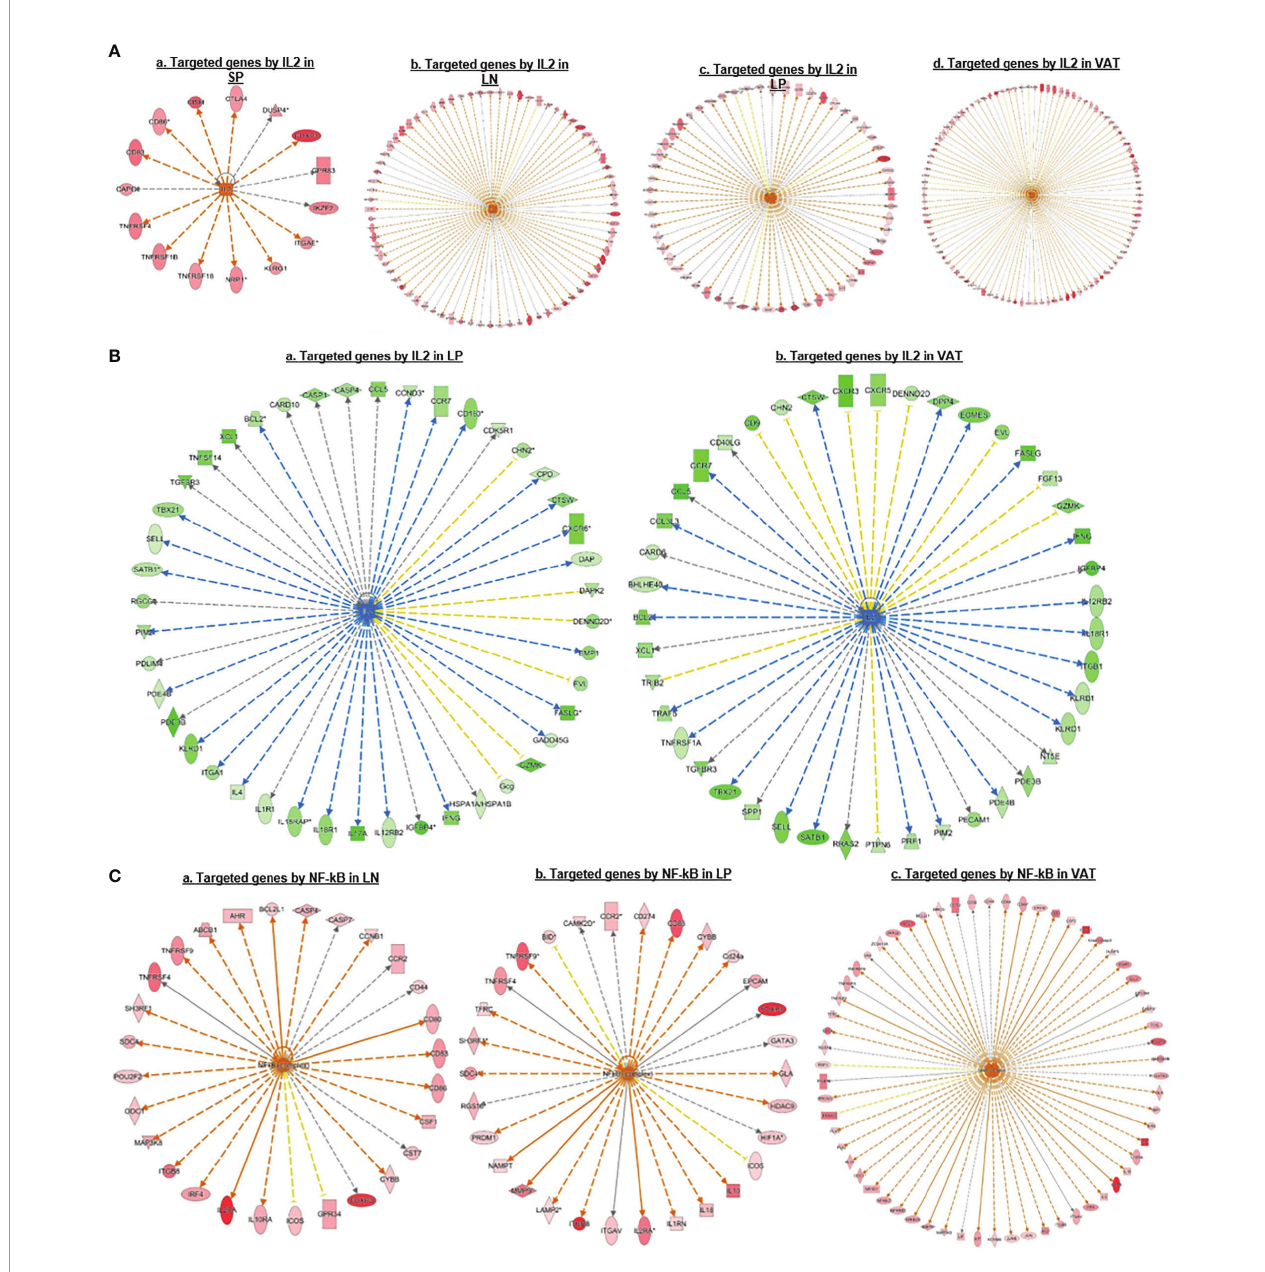
FIGURE 4 | (A) IPA upstream regulator predictions of upregulated genes in Treg suggest that IL 2 is a universal regulator of Treg in different tissues; and its function could be ampli fi cated from lymphoid tissues to non-lymphoid tissues. We also found that many signature genes we identi fi ed were targeted by IL2, such as CTLA4, FOXP3, IKZF2, KLRG1, TNFRSF18, TNFRSF4, etc. (B) IPA Upstream regulator predictions of downregulated genes also suggest that IL 2 is a universal regulator of Treg in non-lymphoid tissues but not in the lymphoid tissues. (C) IPA Upstream regulator predictions of upregulated genes suggesting that NF-kB is a universal regulator of Treg in different tissues except spleen. We found that upregulated signature genes such as FOXP3, IL2RA, TNFRSF4, and IRF4 were parts of NFkB targets, indicating the important role of NFkB in Treg